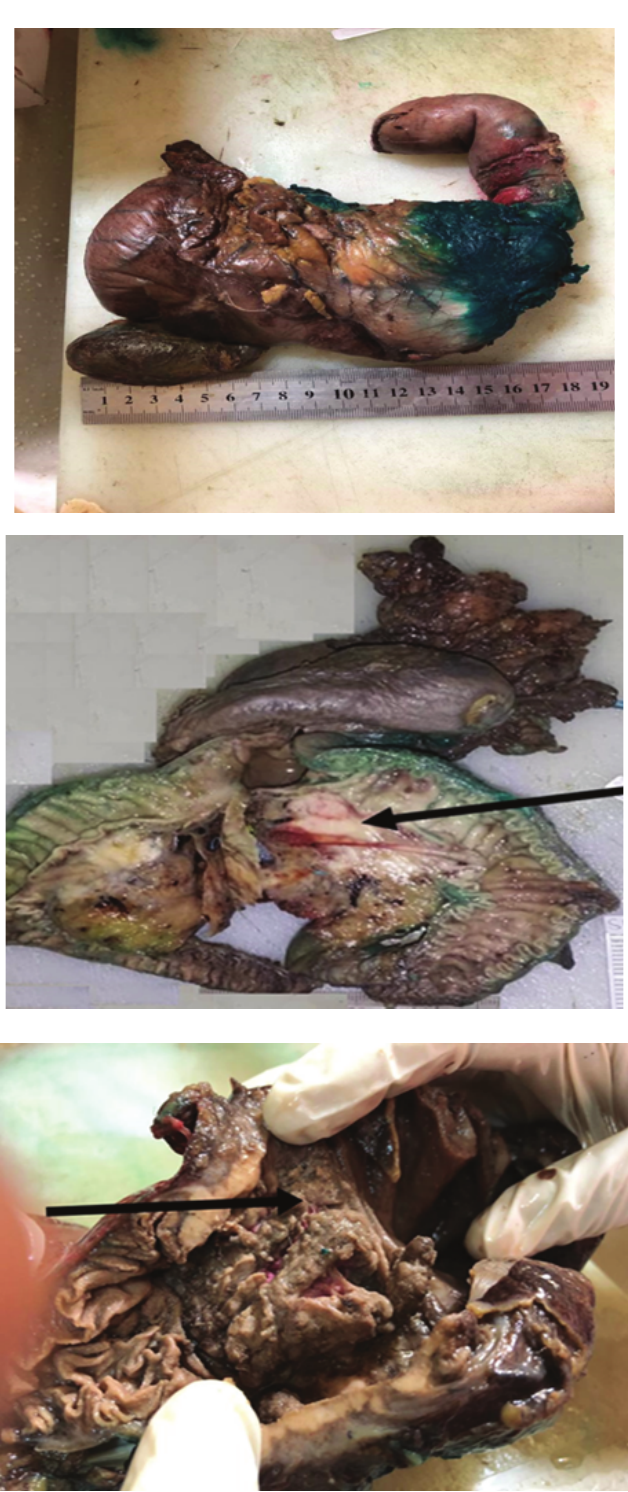
Figure 1 : Whipple specimens: (a) outer surface; (b) cut section showing tumor at the head of pancreas; and (c) head of pancreas tumor involving both the ampulla and the